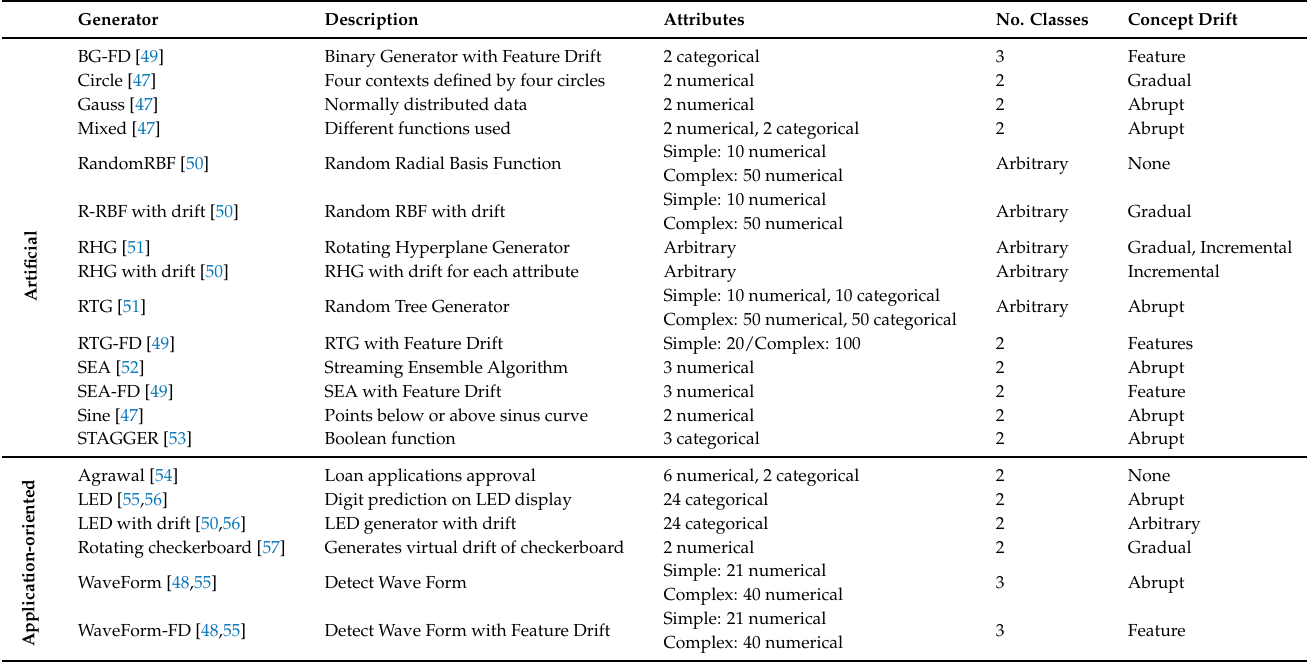
Table 2. Synthetic data generators from different application scenarios of stream classification. Above the horizontal line, we summarized artificial generators, while we considered application- oriented generators below.